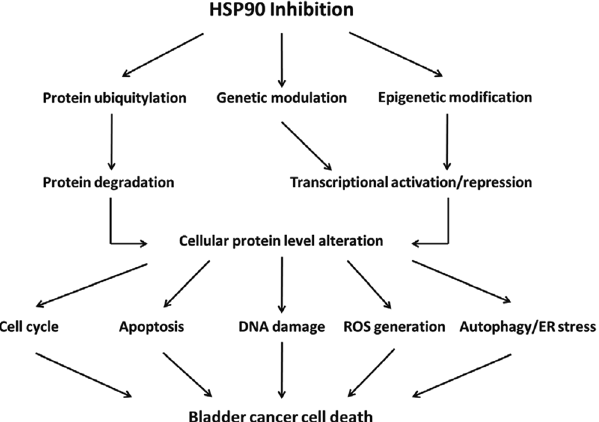
Figure 6. The proposed potential mechanisms of heat shock protein 90 (HSP90) inhibition lethality in bladder carcinoma cells. This schematic diagram shows that HSP90 inhibitors can substantially alter cellular protein levels directly or indirectly through inhibition of HSP90 leading to rapid ubiquitinylation and degradation of oncogenic client kinases and proteins, or through induction of genetic and epigenetic regulation of gene expression leading to changes of protein levels. These proteins with altered expression are involved in the intracellular signaling pathways of cell cycle progression, apoptotic cell death, DNA damage repair, oxidative stress, autophagy regulation, and endoplasmic reticulum (ER) stress, which are all implicated in cancer cell death. Such a mechanism may serve to integrate the roles of proteasomal degradation, genetic modulation, and epigenetic modification in culmination in misregulating cellular protein expression and cell death, which may underlie the mechanism of HSP90 inhibitor-mediated protein level alteration and cell killing in bladder cancer cells. See the text for details. ROS, reactive oxygen